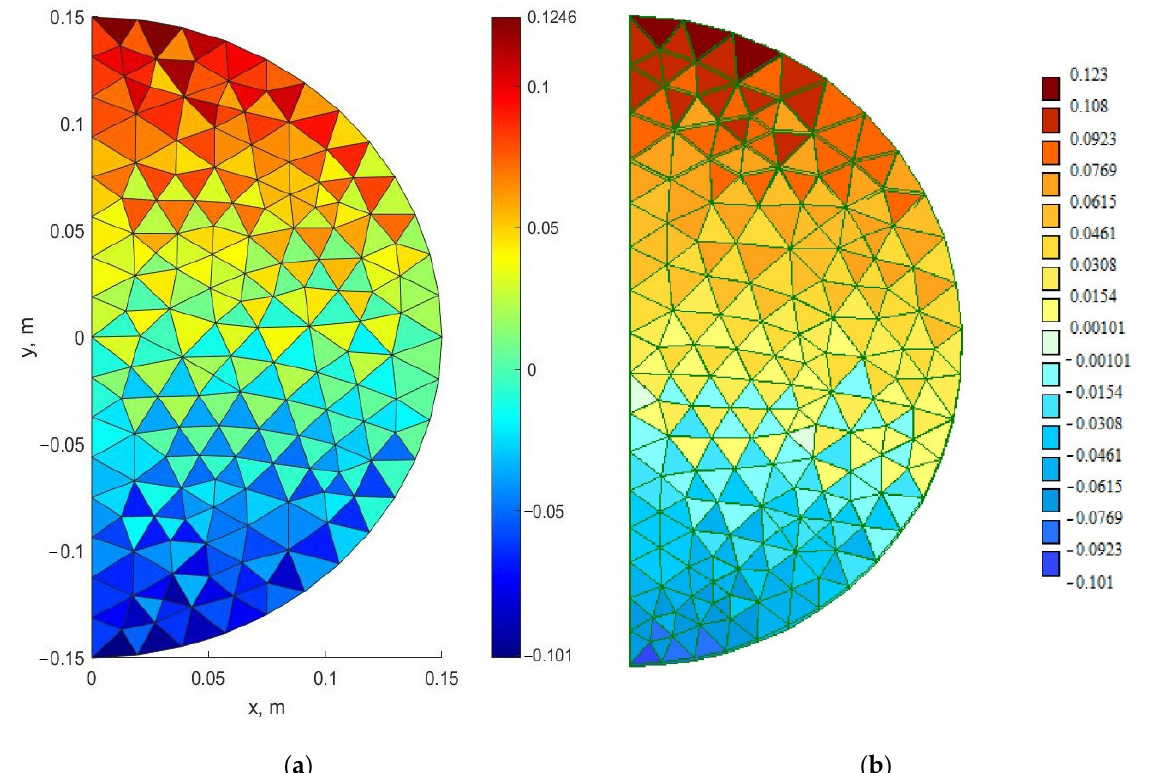
Figure 6. Mosaic of stresses σ x (MPa): ( a ) MATLAB; ( b ) LIRA-SAPR.